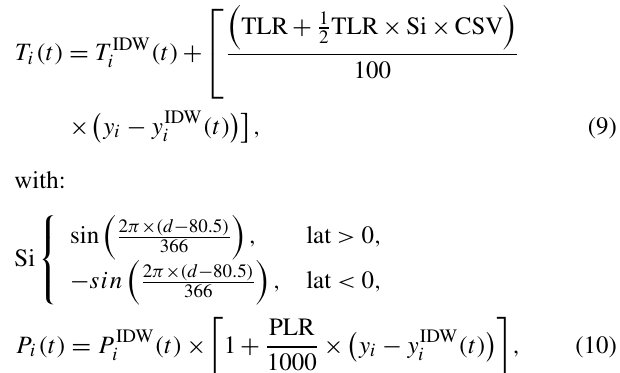
elevation zone from gridded temperature and